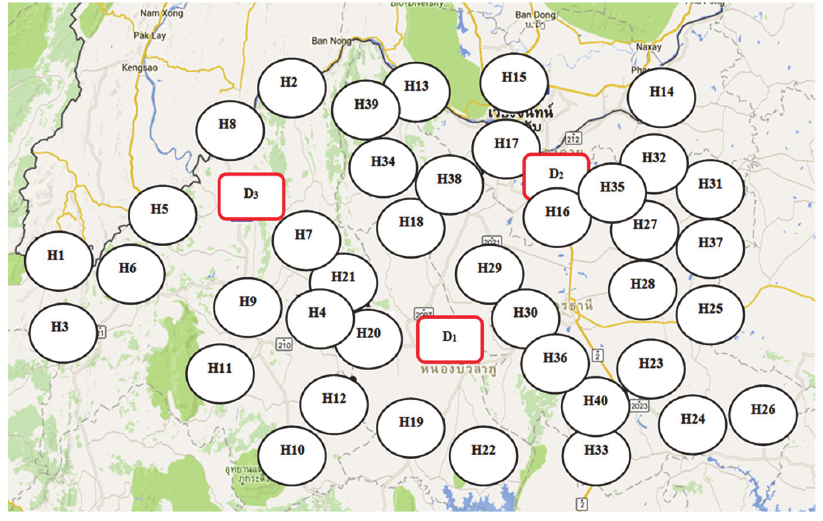
Fig.3. The transshipment network for candidate municipalities and